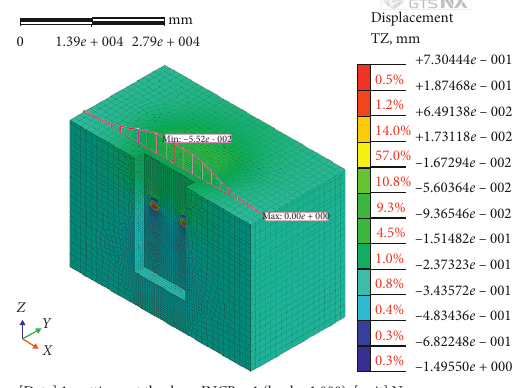
Figure 11: Surface subsidence diagram at 1 m of lateral reinforcement.